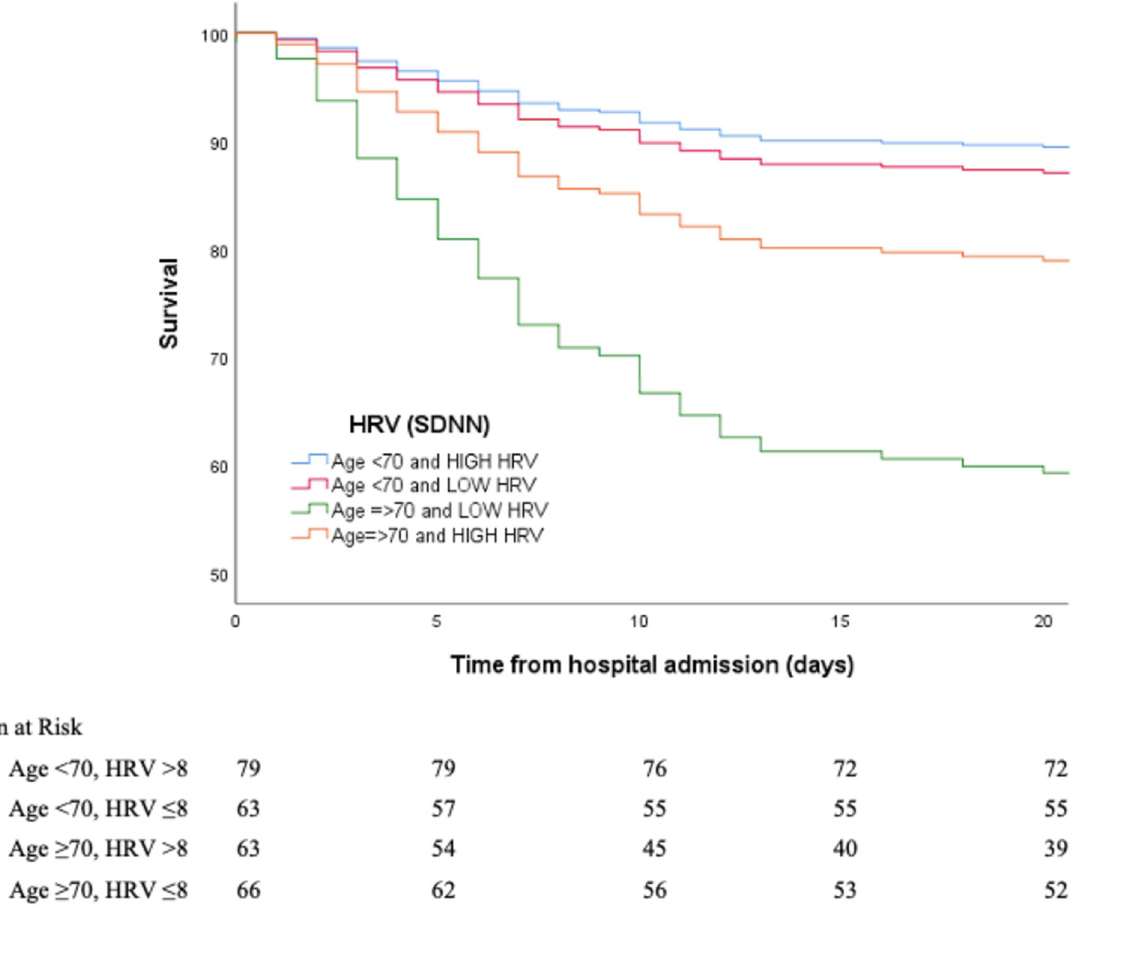
Fig 1. Effects of age on mortality from COVID-19 as a function of vagal nerve activity (HRV).